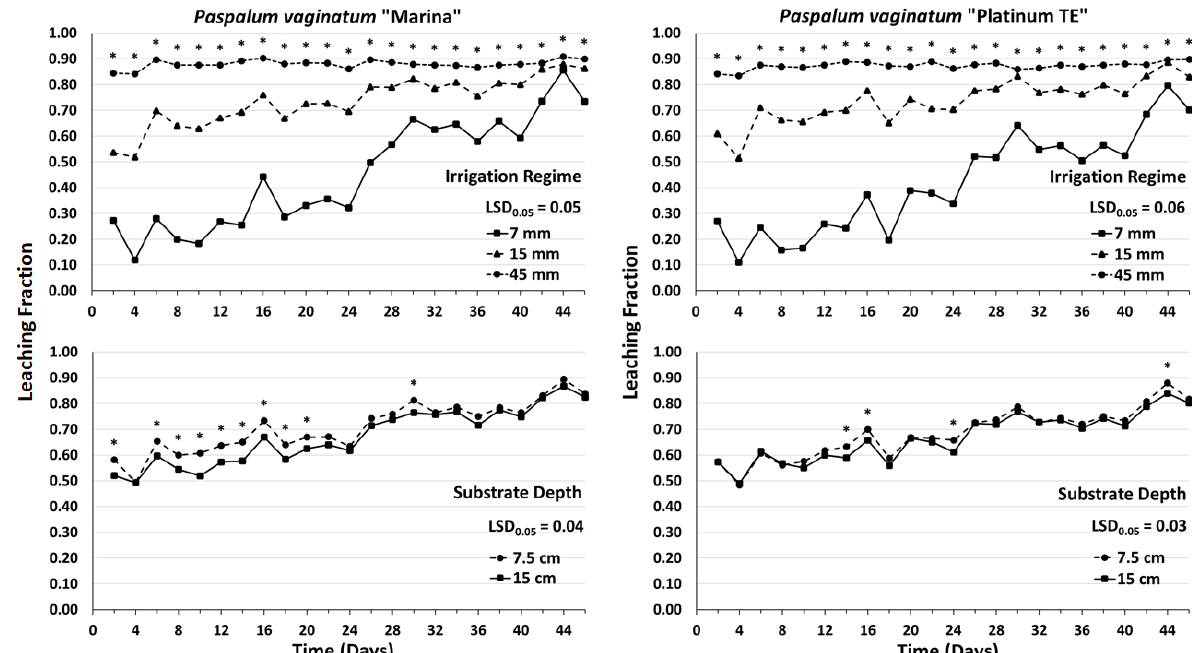
Figure 3. Leaching fraction of the two Paspalum vaginatum varieties “Marina” and “Platinum TE”, as affected by seawater irrigation regimes (7 mm, 15 mm, or 45 mm) and green roof substrate depth (7.5 cm or 15 cm) during the salinity stress period (29 July–13 September 2016). Values are the mean of 4 replications. Asterisks (*) indicate significant differences in-between treatment means on a single sampling date, according to Fisher’s least significant difference (LSD) at p < 0.05 following the repeated measures